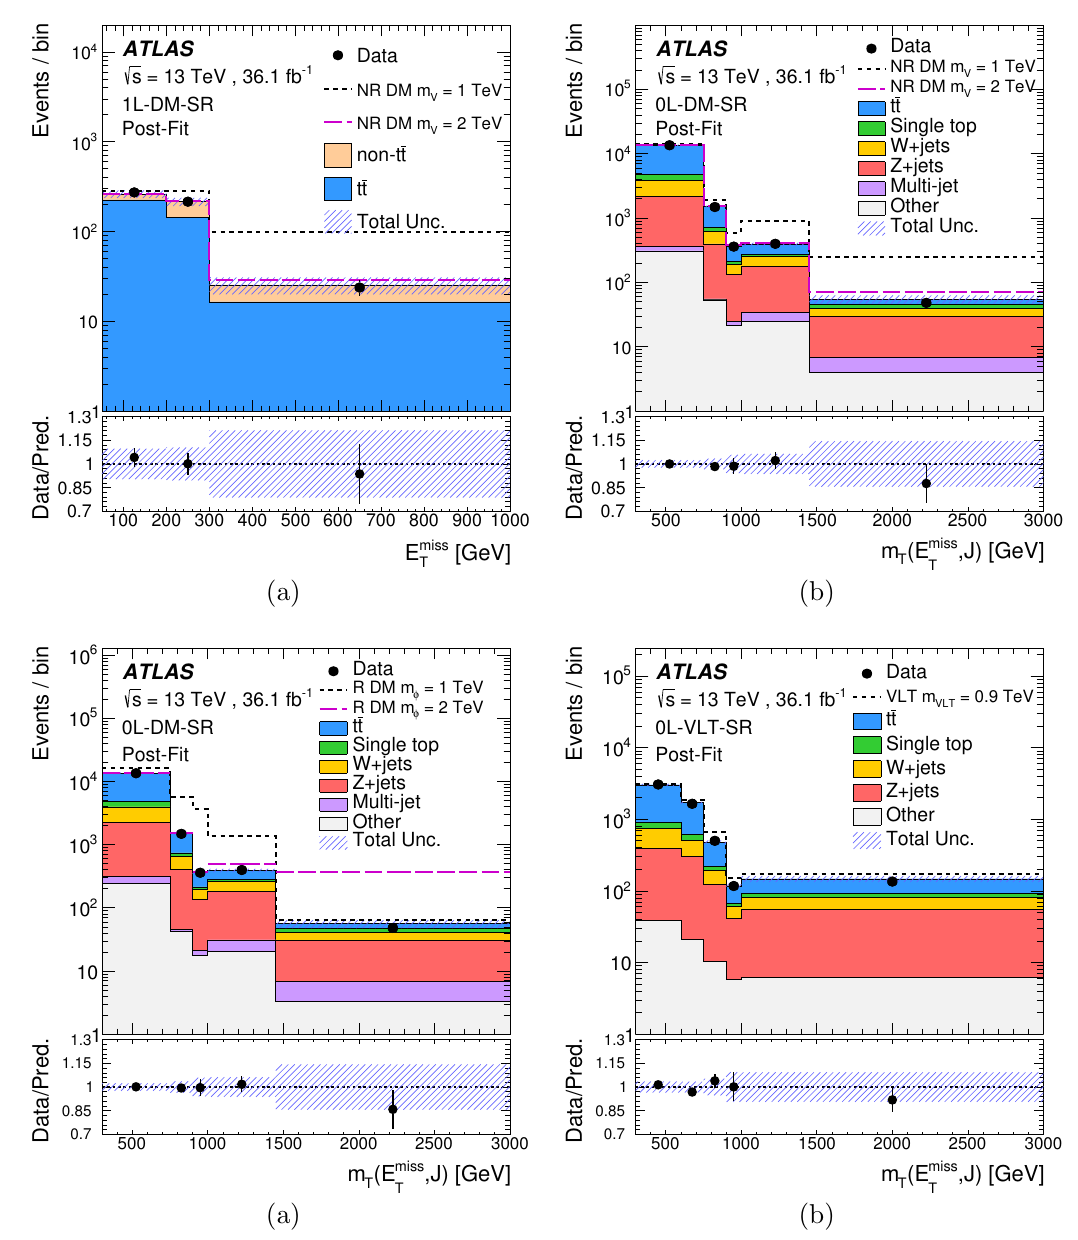
Figure 3 . Comparison of data and (cid:12)tted expectations for the E miss and the transverse mass of the T top-tagged large- R jet and E miss system, m T ( E miss ; J ), distributions in the signal regions. Other T T backgrounds in the 1L regions include multi-jet, Z +jets and diboson contributions, while in the 0L regions it is composed of diboson and t (cid:22) t + X contributions. The background-only hypothesis is used in the (cid:12)t: (a) and (b) including the 1L and 0L DM signal regions as well as the 1L and